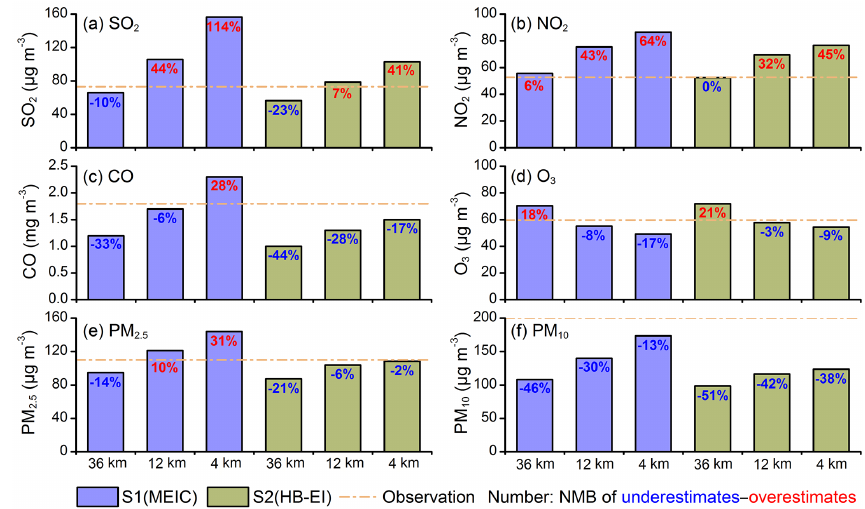
Figure 6. Evaluations against in situ measurements for atmospheric modeling using MEIC and HB-EI inventories at 36, 12, and 4km. The air pollutants used for evaluation include (a) SO 2 , (b) NO 2 , (c) CO, (d) O 3 , (e) PM 2 . 5 , and (f) PM 10